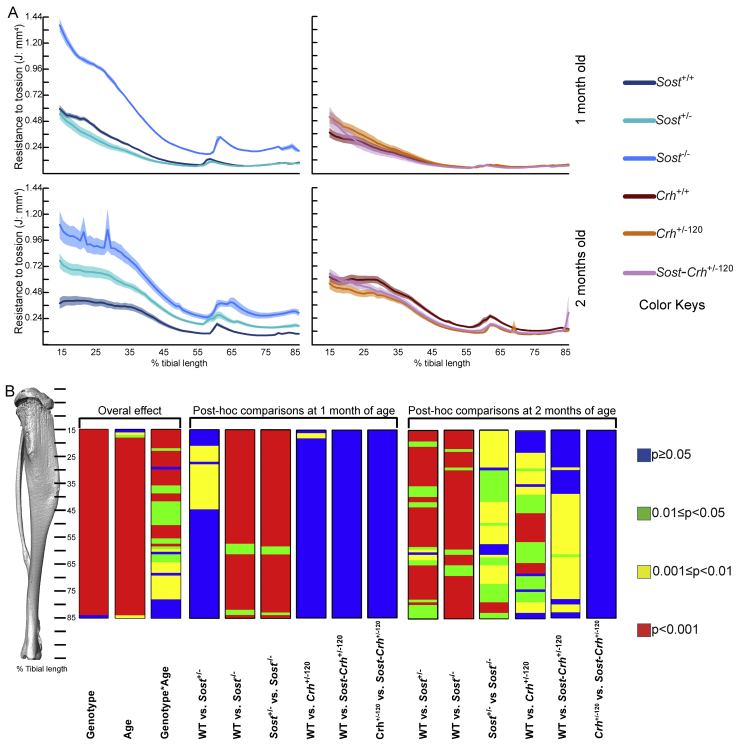
Sost haploinsufficiency does not rescue reduced resistance to torsion (J) induced by excessive glucocorticoids (GCs). A: J in Sost wild-type (WT) (dark blue; Sost+/+ WT), Sost heterozygous knockout (KO) (light blue; Sost+/−), Sost homozygous KO (turquoise; Sost−/−), Crh WT (dark red; Crh+/+), Crh heterozygous (orange; Crh+/−120), and double Sost-Crh heterozygous (plum; Sost-Crh+/−120) mice at 1 and 2 months of age. Lines represent the means; shading, the SEM. B: Graphic heatmap representation of statistical significance of the effect of genotype, age, their interactions as well as post hoc analysis along a 15% to 85% portion of the whole tibia length, excluding proximal and distal metaphyseal bone. n = 8 mice per group.